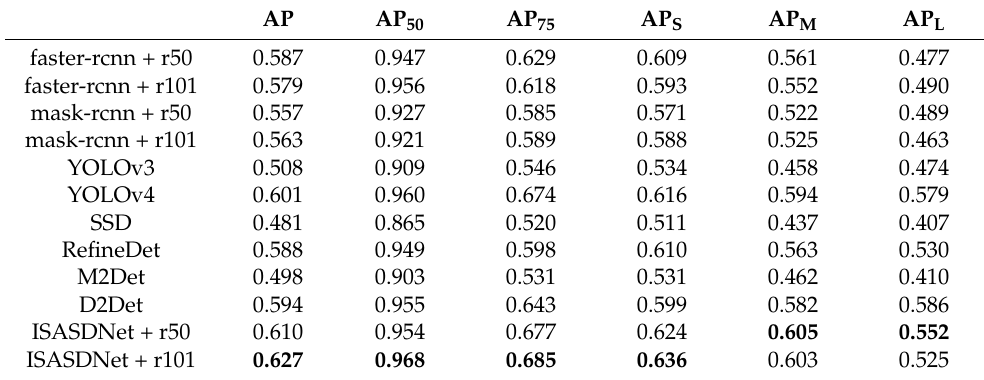
Table 4. AP of different methods on